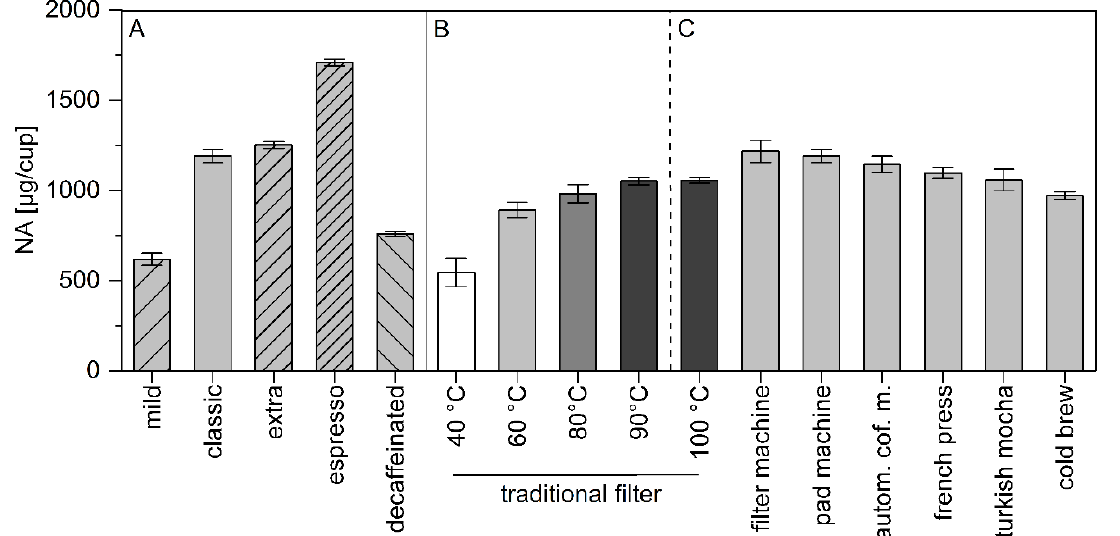
Figure 1. Nicotinic acid (NA) contents [mg/cup] of ( A ) five different coffee samples (all 100% arabica) prepared by pad machine (Ø cup volume 112 mL); ( B ) coffee sample brewed at different